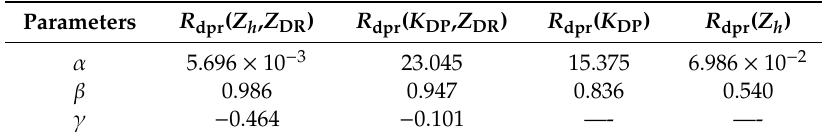
Table 4. The fitted parameters of radar QPE estimators (Equations (15)–(18)) derived using the total DSD